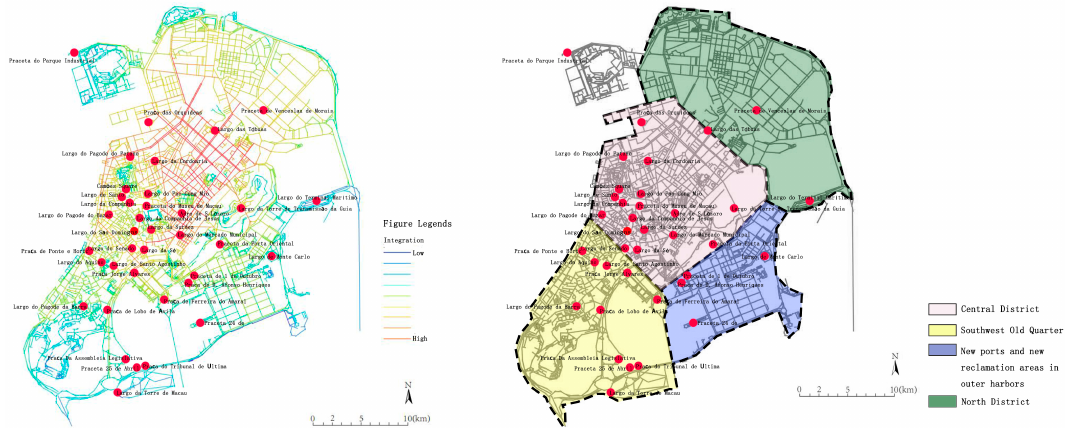
Figure 8. The global degree of integration and the location of Largos in the Macau Peninsula.